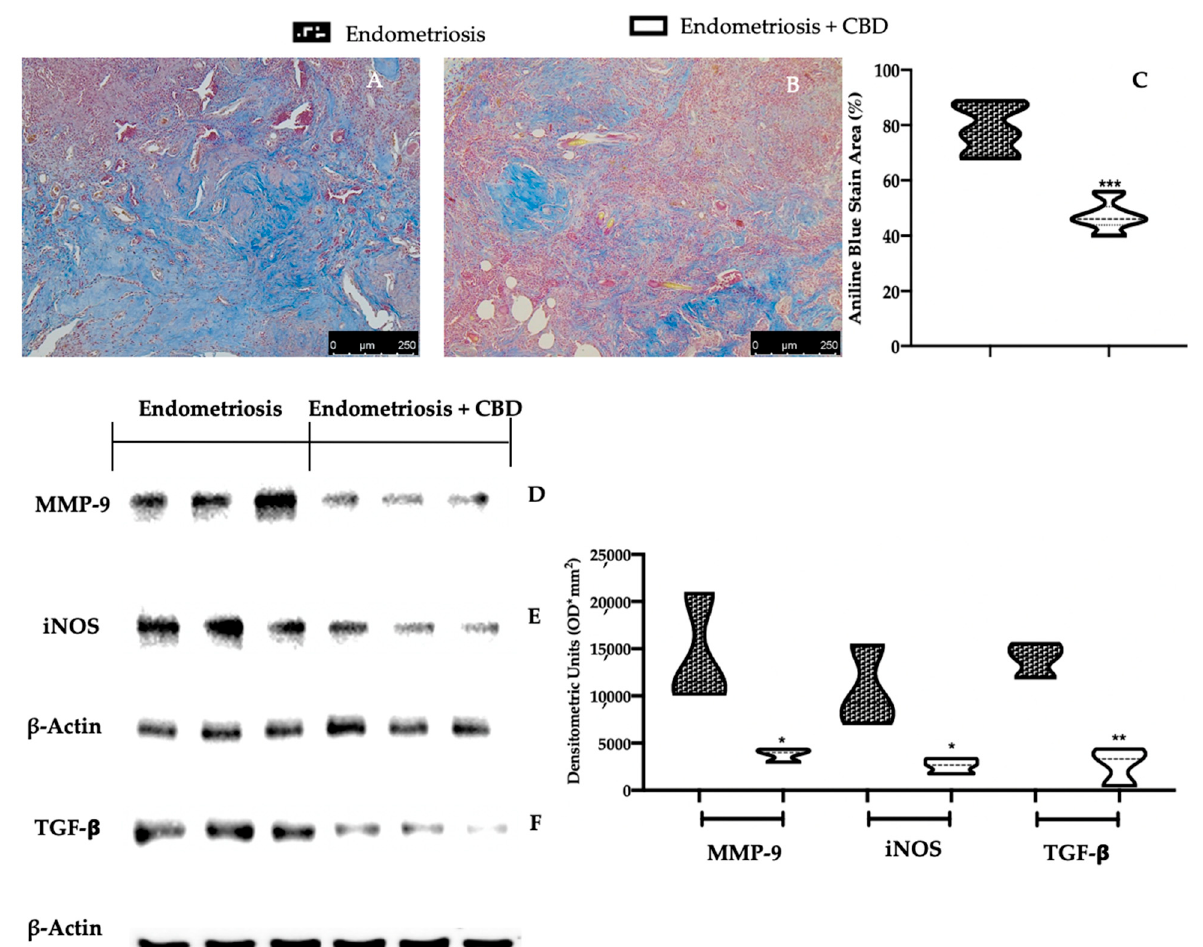
Figure 3. CBD administration reduced fibrosis endometriosis-induced: Masson trichrome staining: vehicle ( A ), CBD ( B ), aniline blue stain area ( C ); Western blot analysis of MMP-9 ( D ), iNOS ( E ) and TGF- β expression ( F ). For each analysis, n = 5 animals were employed. For the Masson trichrome staining, n = 5 different fields from n = 5 different animals were evaluated. * p < 0.05 vs. endometriosis, ** p < 0.01 vs. endometriosis, *** p < 0.001 vs. endometriosis.